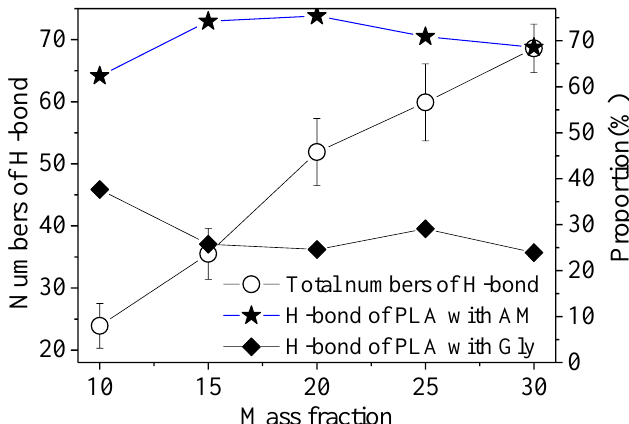
Figure 6. The relationship between the total number of H-bonds, the proportion of H-bonds of PLA-AM, and the proportion of H-bonds of PLA-Gly with the mass fraction of thermoplastic starch.